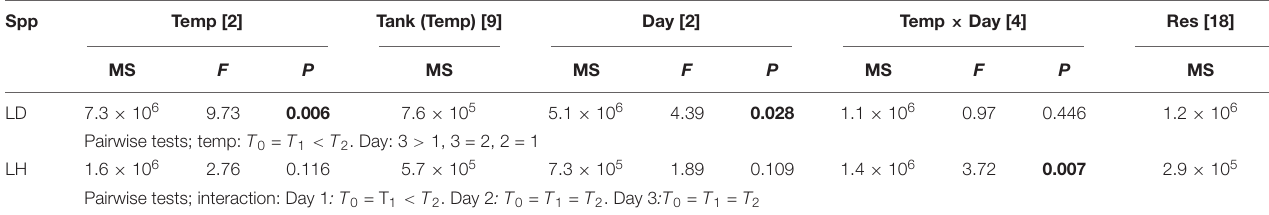
TABLE 1 | The effect of temperature treatment, tank and experimental day on net oxygen flux as determined by RM ANOVA for both Laminaria digitata and Laminaria hyperborea .